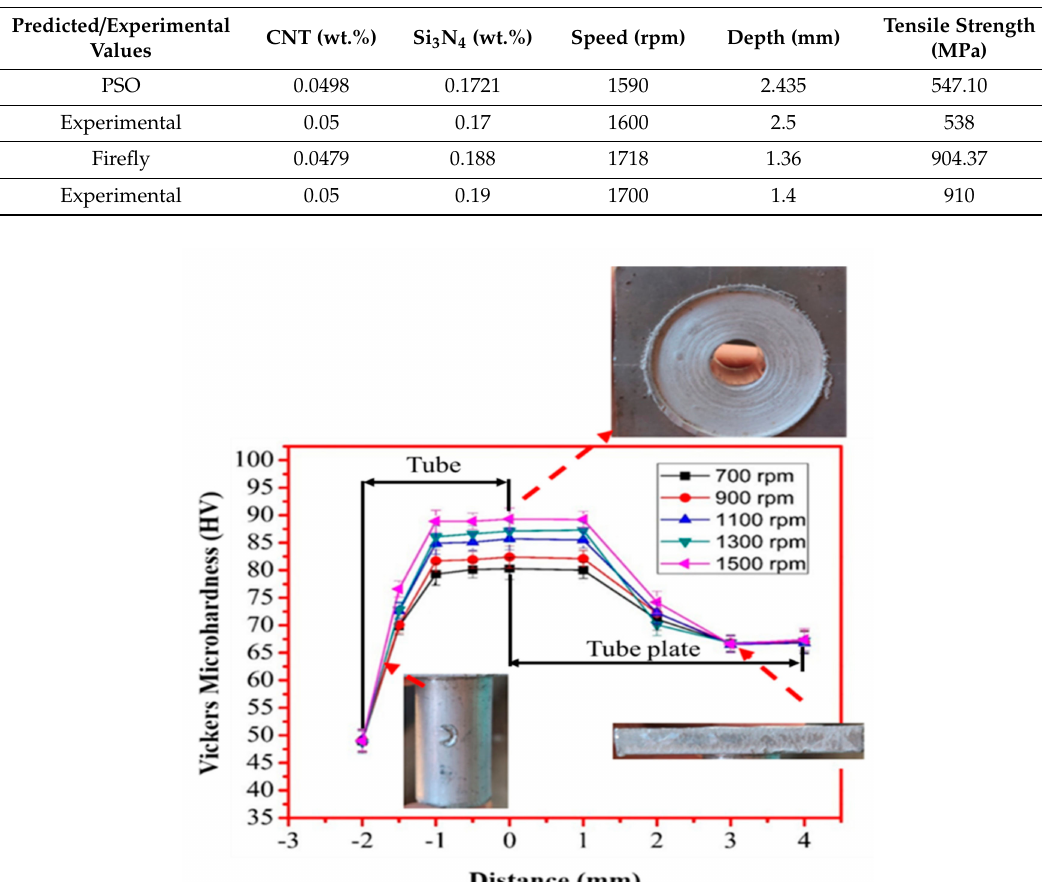
Figure 9. The typical Vickers microhardness profile of specimen subjected to the FWTPET + FSP